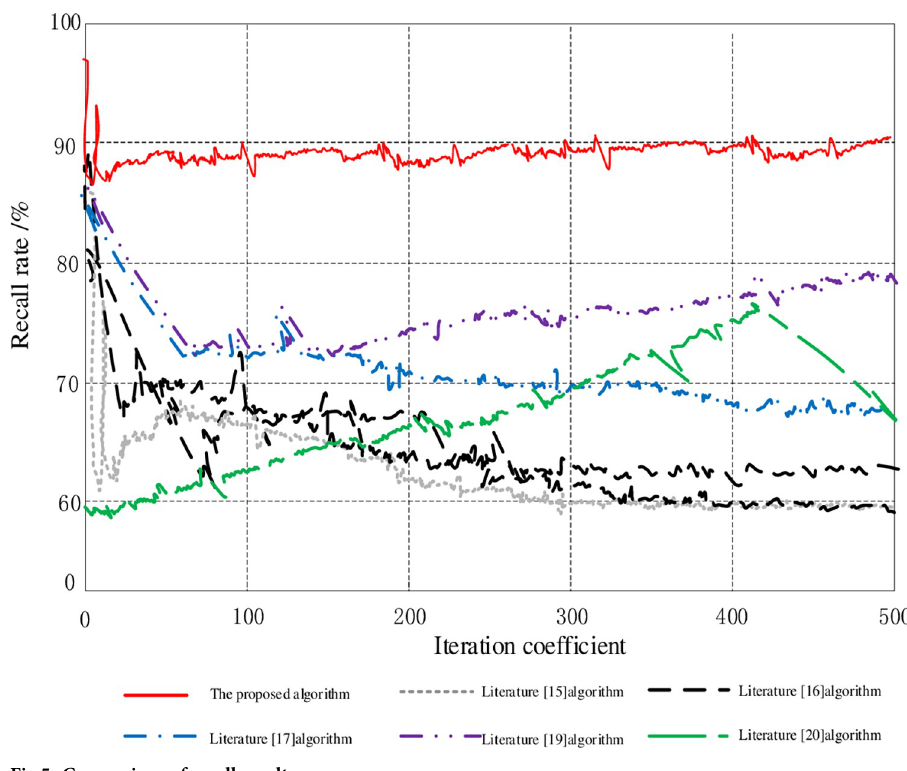
Fig 5. Comparison of recall